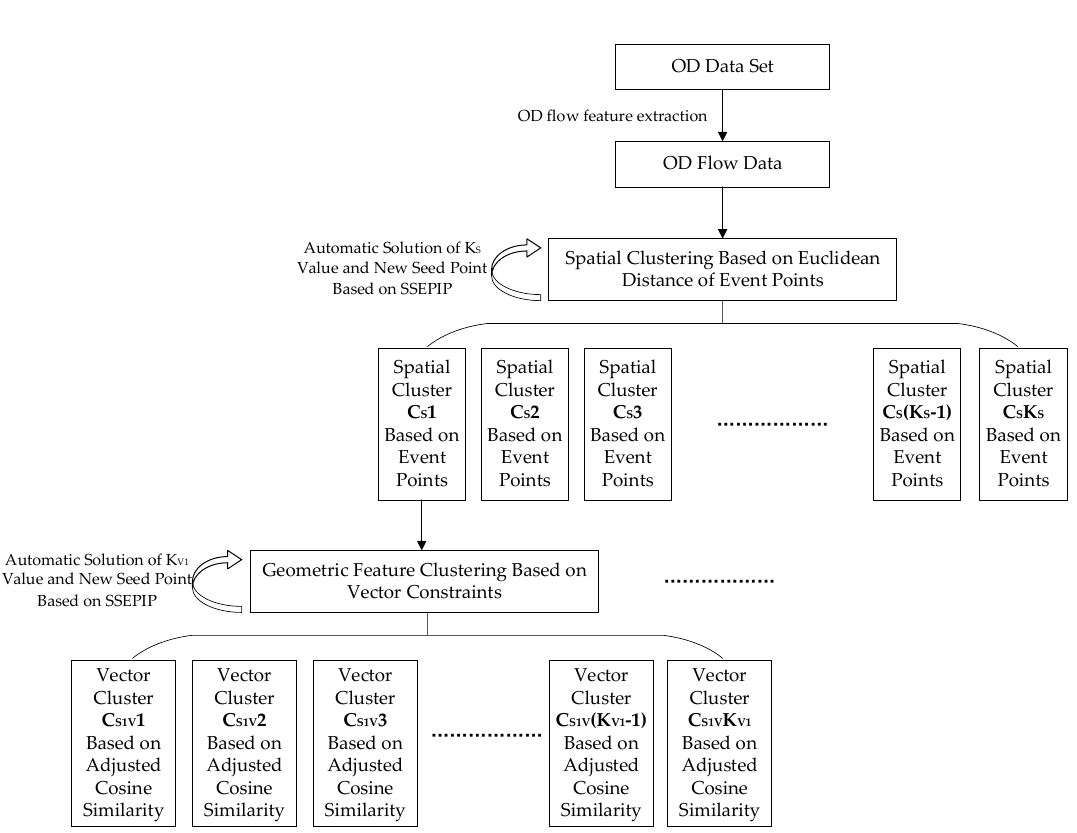
Figure 7. Origin-destination flow clustering vector constraints (ODFCVC) method flow chart.